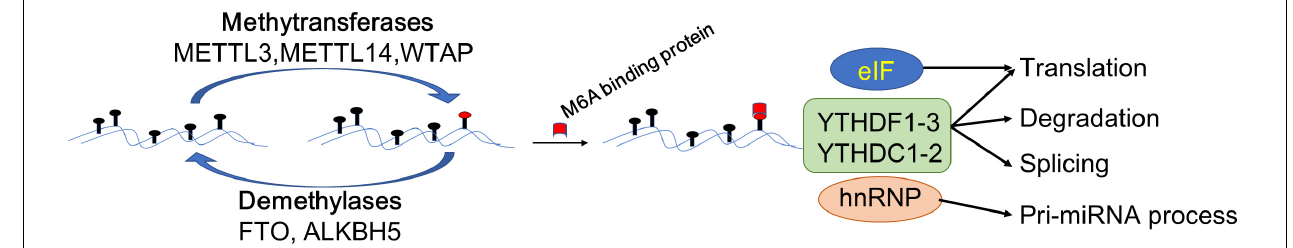
FIGURE 1 | Schematic elucidation of m6A modification in the regulation of gene expression. The m6A modification is catalyzed by methyltransferases METTL3/14, Wilms tumor 1-associating protein (WTAP). The demethylases fat mass and obesity-associated protein (FTO) and AlkB homolog 5 (FTO/ALKBH5) demethylated the bases modified by m6A. Methylated reader proteins recognize the mRNA modified by m6A, thereby activating downstream pathways by different reader proteins. After modified by methyltransferases, eIF3 proteins promote mRNA translation. HNRNPA2B1 regulates the processing of the pre-miRNA and pri-miRNA. Further, YTHDF1-3, YTHDC1-2 can regulate the processes of RNA translation, degradation, and